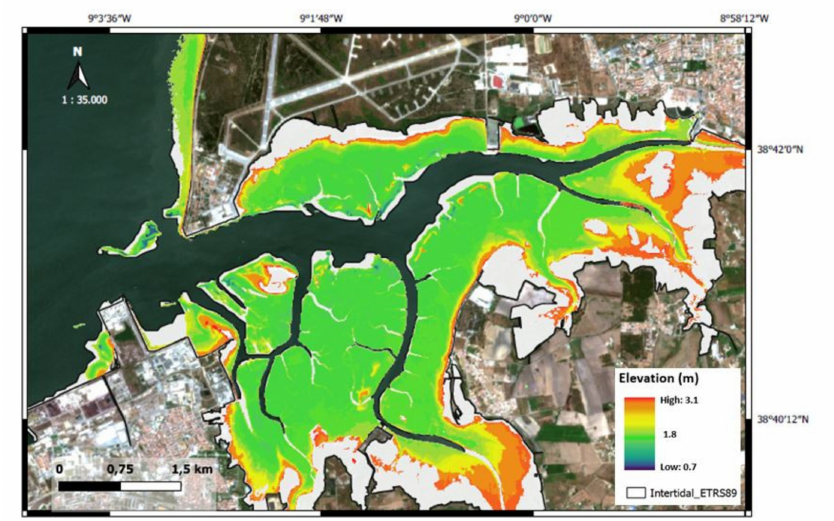
Figure 11. Comparison between derived intertidal model in Tagus estuary and cartographic intertidal area shown in white. Greatest di ff erences are observed along the navigation channel due to intense maritime tra ffi c in the